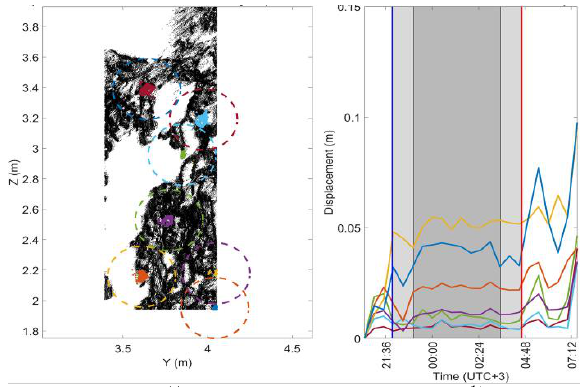
Figure 6. An example of overnight circadian rhythm monitoring in a Silver Birch branch between 16/ May - 8 PM to 17/May - 8 AM using the TLS measurement station data: (a) clusters selected in the branch and (b) the displacements of their centres from the initial locations, correspondingly The seasonal phenology monitoring is demonstrated with the Figure 5. Example of point cloud colourized by range parameter point clouds collected from the silver birch branch structure in values (0 - 290m) acquired by the TLS measurement station four dates. The collection times were in middle spring (18/April), during the pilot project (April). The dashed and solid bounding summer (18/June), autumn (18/Sept) and late autumn box show the position of the birch tree and its branch, respectively. Their phenological changes were studied with more detail.